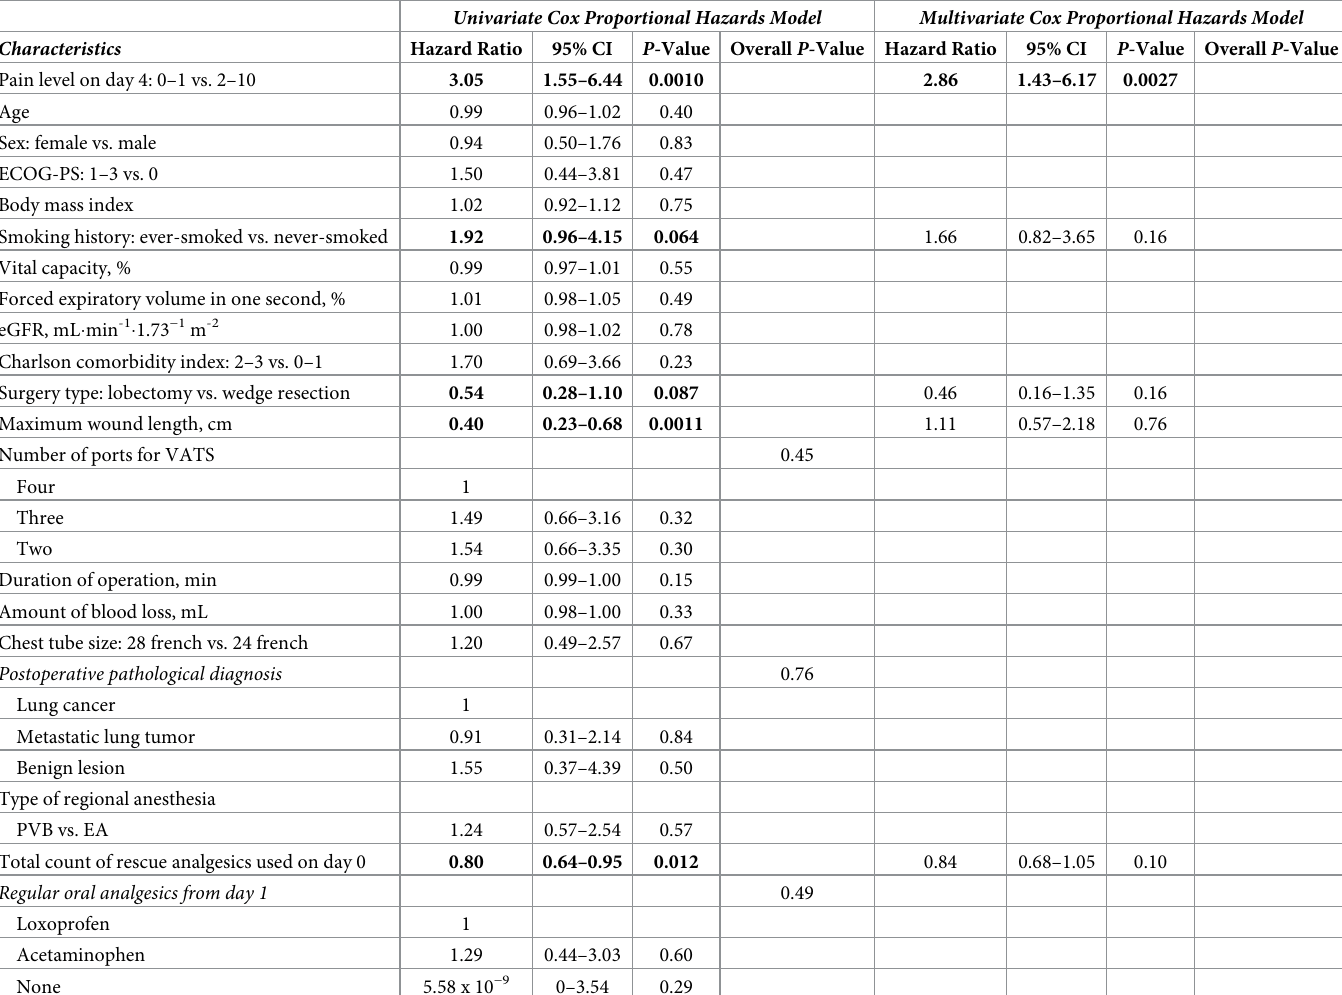
Table 2. Univariate and multivariate Cox proportional hazards models for recovery of pain to mild level (N =